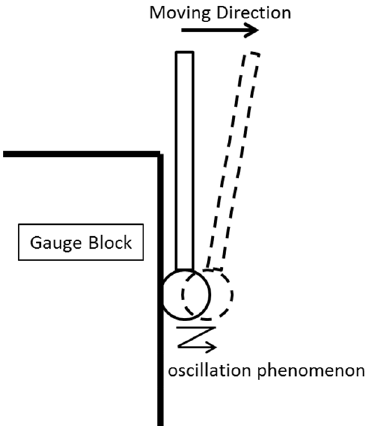
Figure 10. Oscillation phenomenon occurred while measuring.